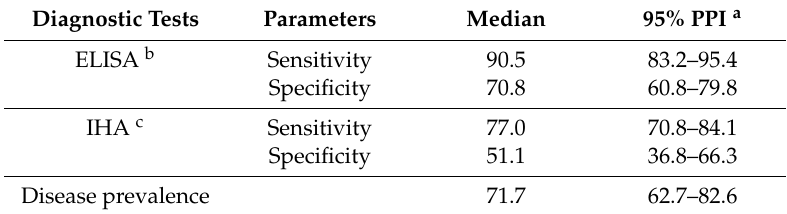
Table 3. Posterior estimates for median and 95% posterior probability interval (PPI) for sensitivity and specificity of ELISA test and IHA test, and prevalence of the disease